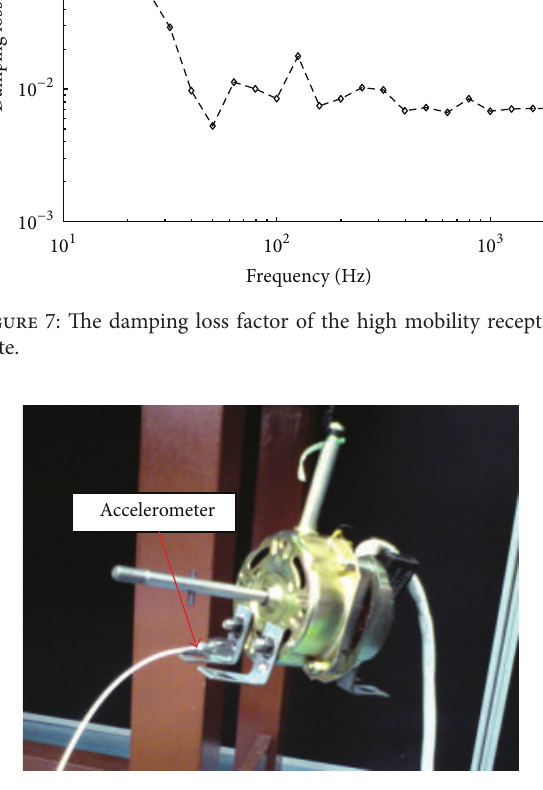
Figure 8: Measuring the free velocity directly at the feet of the fan motor running at normal speed.